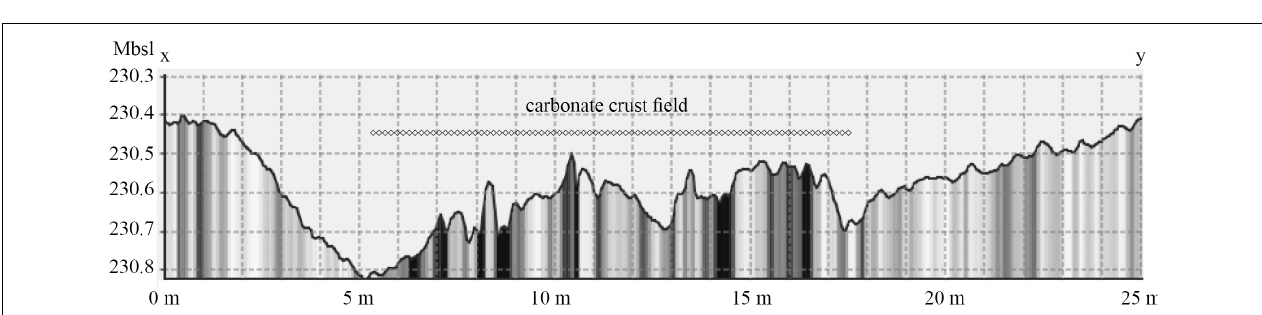
FIGURE 6 | Bathymetric profile across the eastern carbonate crust field in subsection of Area 1 (profile line x–y is shown in Figure 4C ). Vertical exaggeration: 10 × .